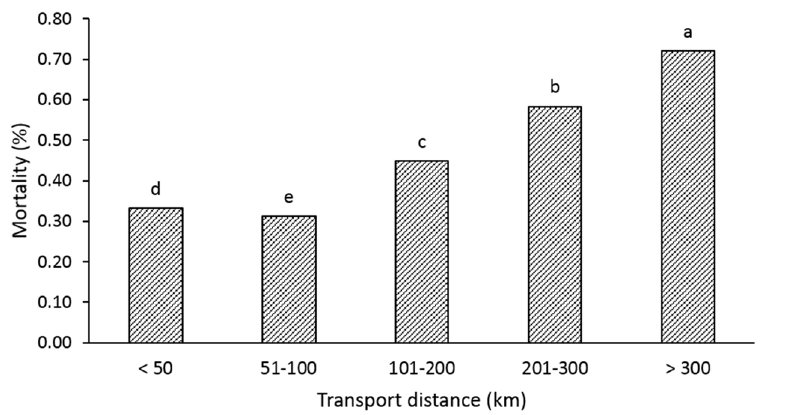
Figure 2. Transport-related mortality of broiler chickens as affected by transport distance. a-e Mortality in columns with different super- scripts differ significantly (p<0.001).